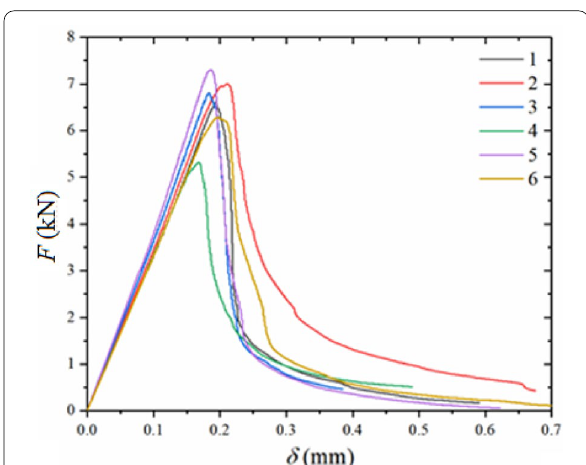
Fig. 5 Experimental curves of load–displacement for the six specimens in the same batch